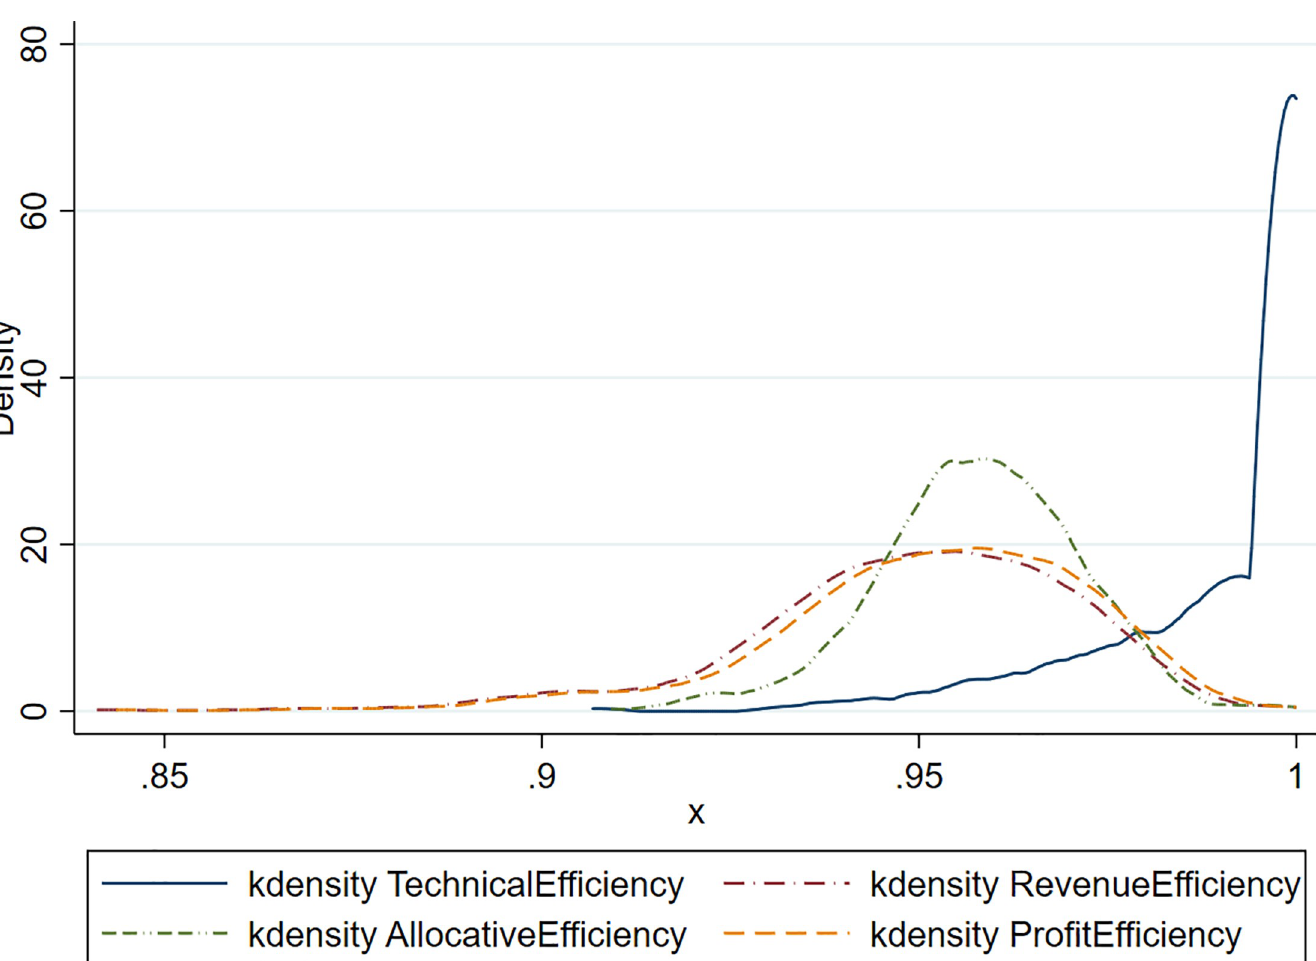
Fig 4. Kernel density estimation of efficiencies including fat, protein, somatic cell count, liveability, udder composition, daughter pregnancy rate and calving ability as outputs in FDH model.